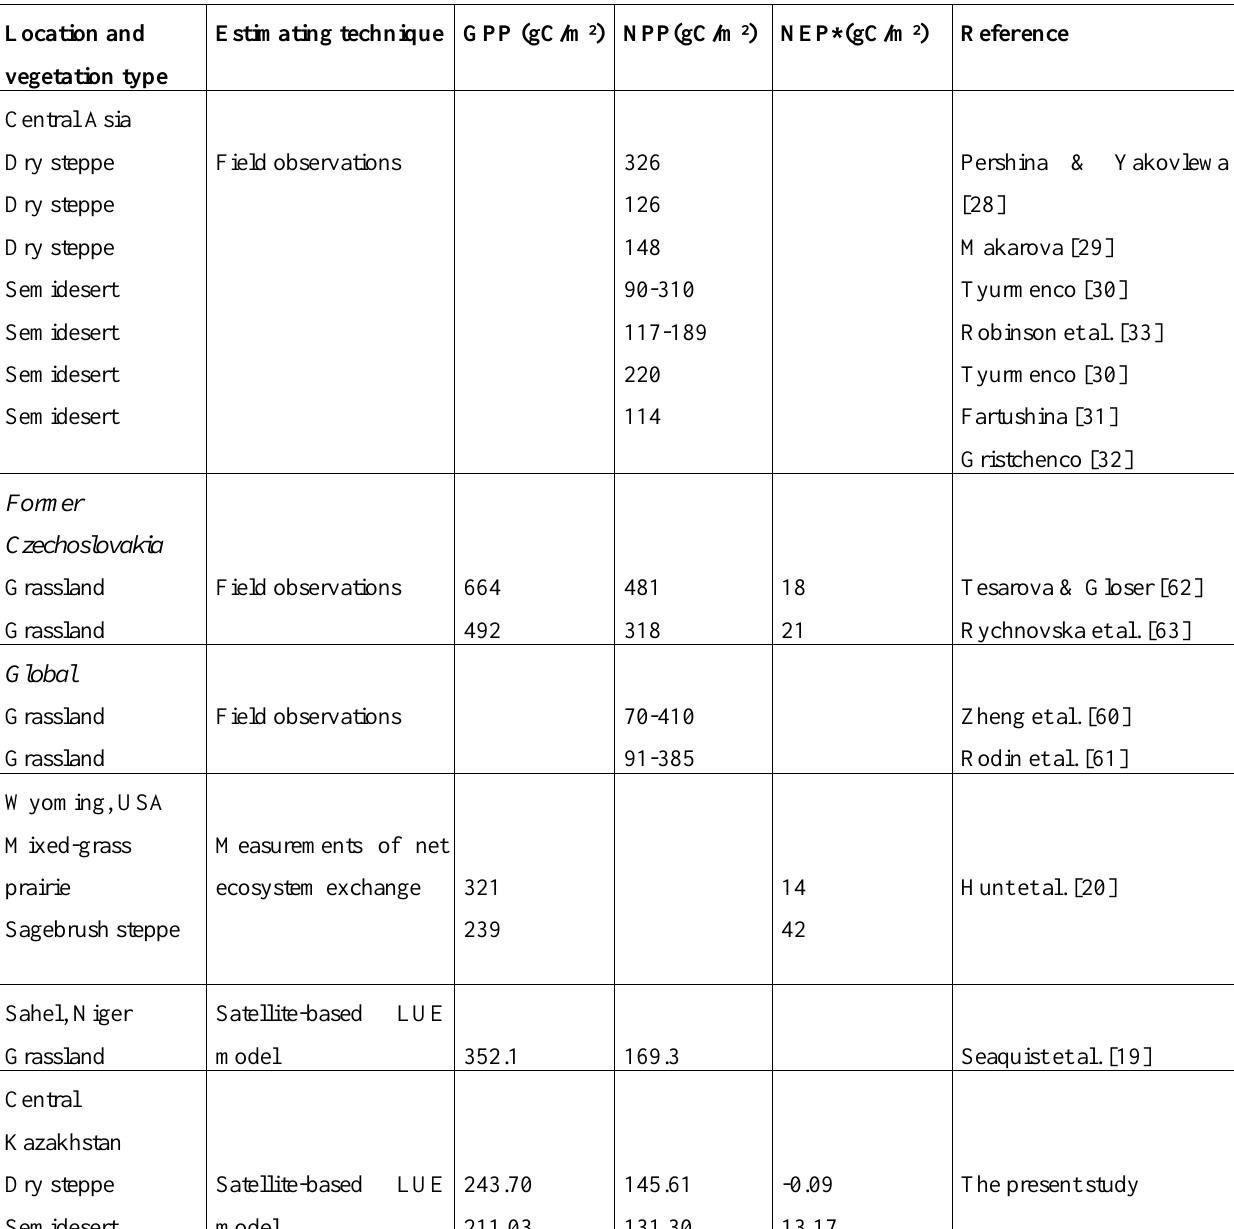
Table 4. Previous estimates of primary production (GPP and NPP) and net ecosystem production (NEP) in arid and semi-arid zones.